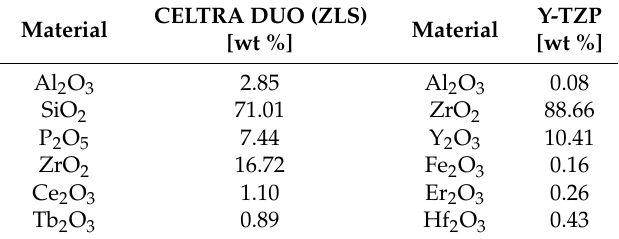
Figure 2. Energy dispersive spectroscopy analysis of zirconium (Y-TZP). Table 1. Mass content (%) of Celtra Duo (ZLS) and zirconium (Y-TZP) by energy dispersive spectroscopy (EDS) analysis.